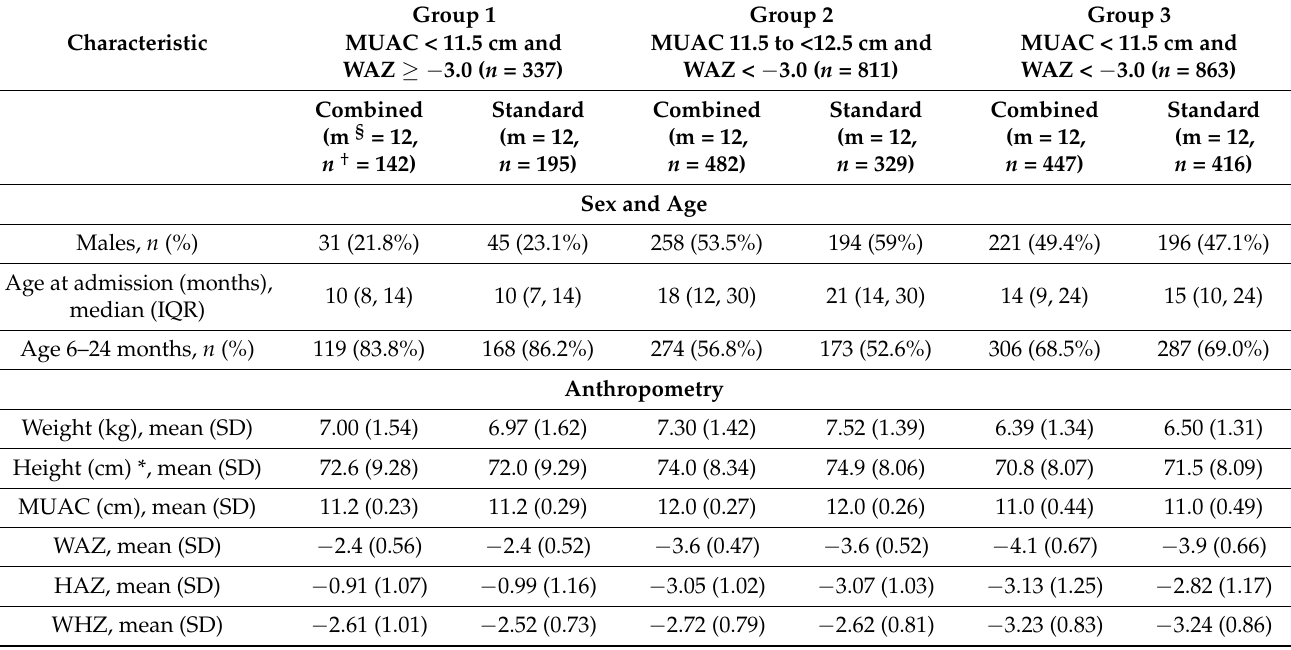
Table 4. Admission characteristics for the three patient groups of interest, by protocol type.